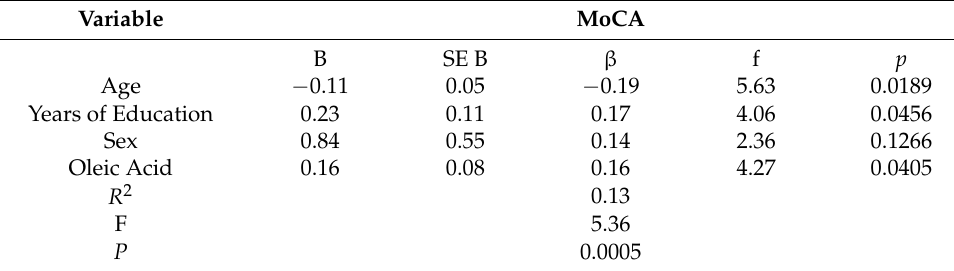
Table 4. Association between MoCA score and consumption of oleic acid.